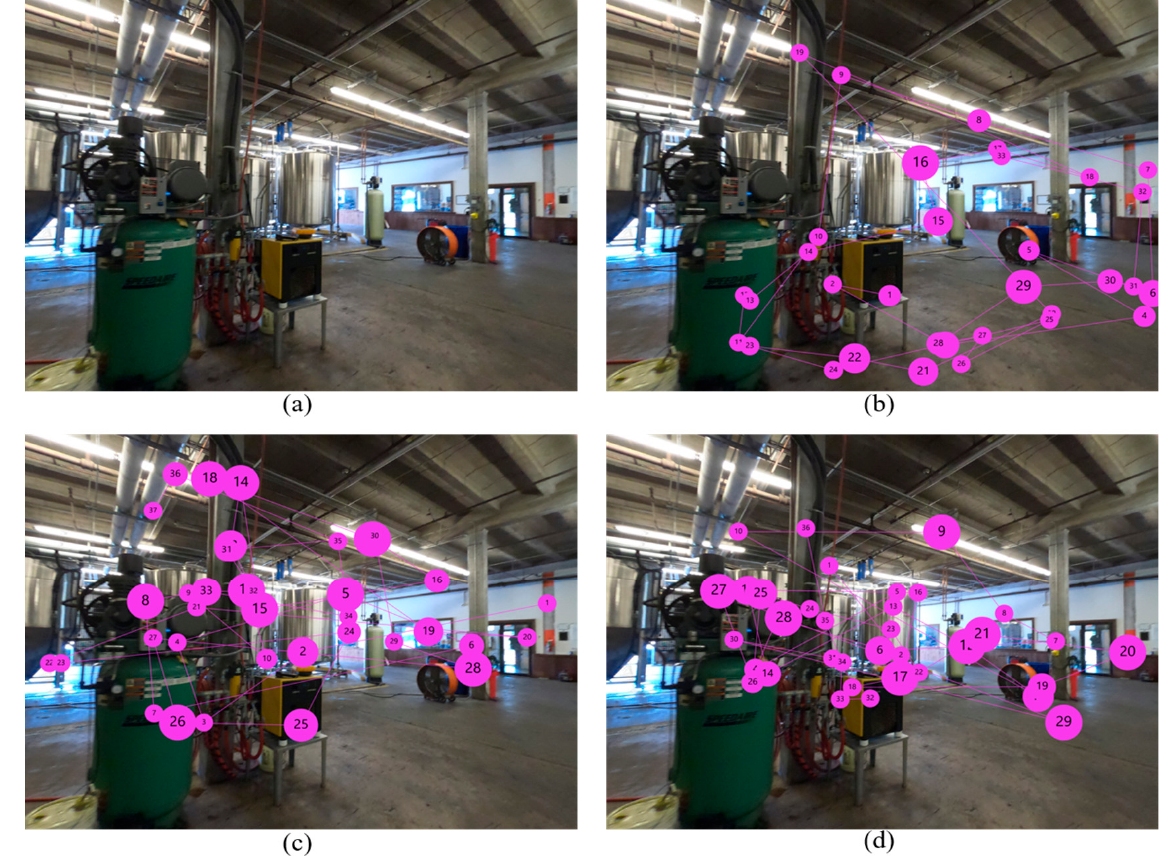
Figure 5. Search pattern (gaze plot): ( a ) original image; ( b ) participant before receiving the in-class training; ( c ) participant after receiving the in-class training; ( d ) experienced participant.